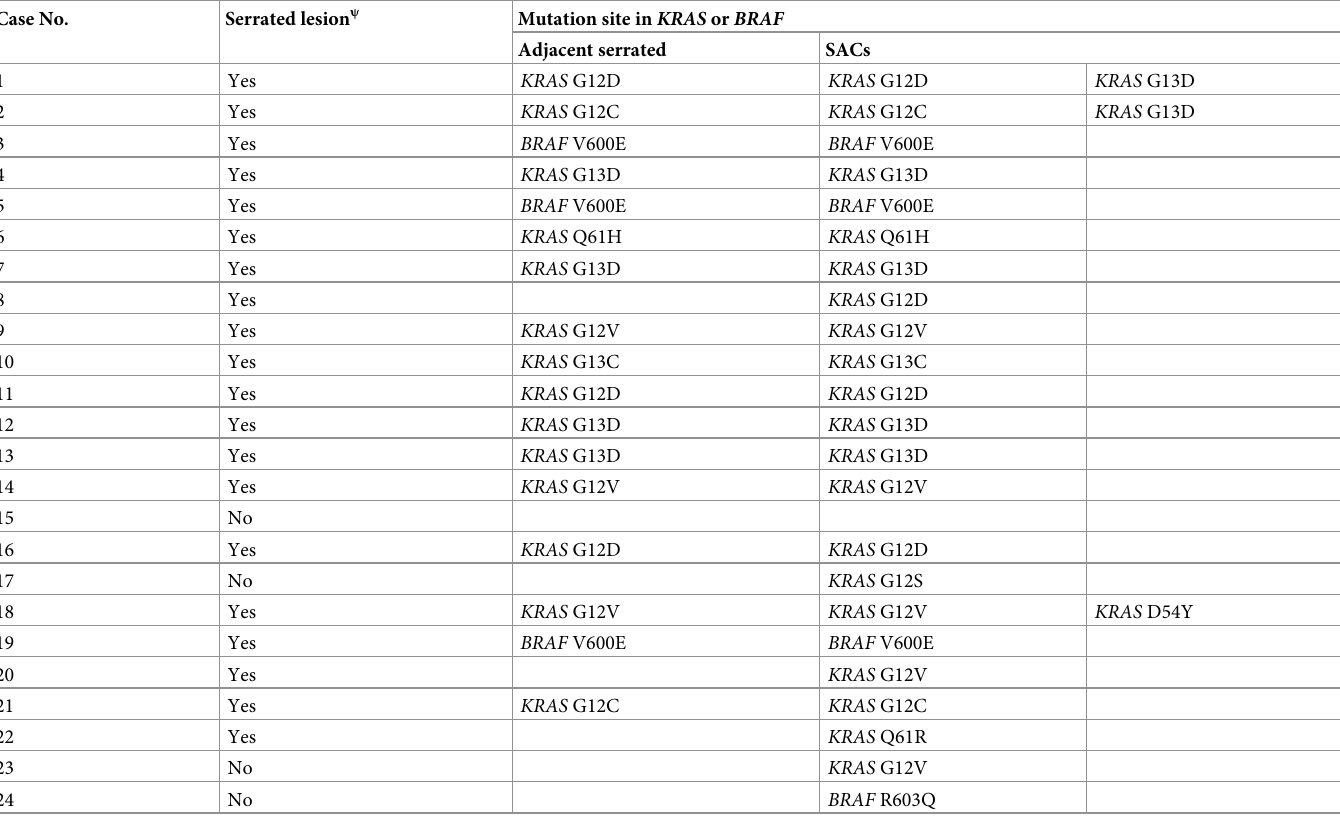
Table 2. KRAS / BRAF mutations in SACs and adjacent serrated lesions. Case